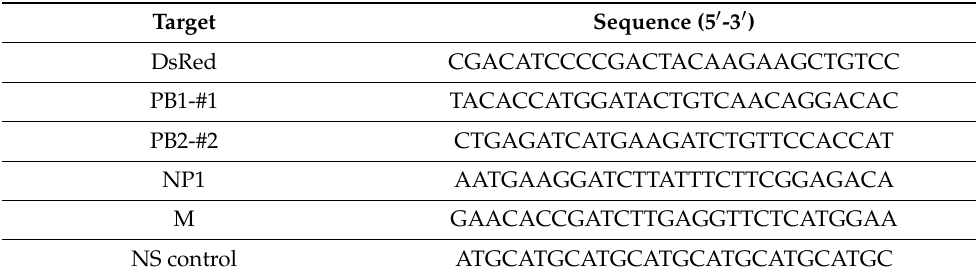
Table 1. List of crRNAs used in the